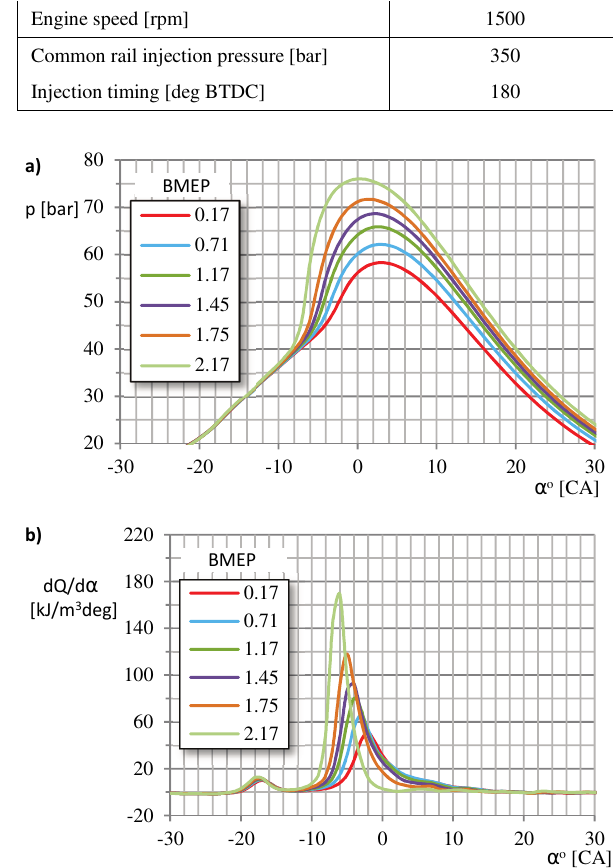
Fig. 4. Pressure diagrams (a) and heat release diagrams (b) for different engine load and constant engine speed (1500 rpm) for fueling with very early injection timing of Jet A-1